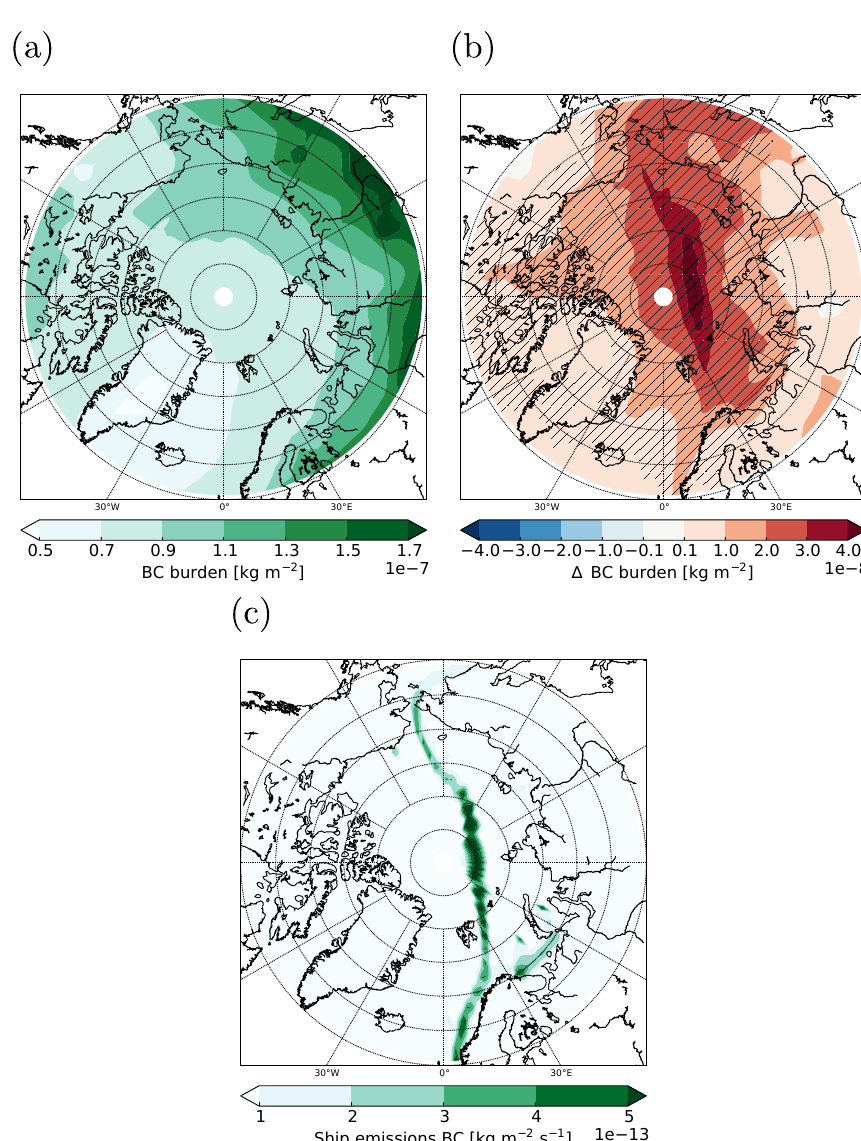
Figure 9. Panel (a) shows the BC burden in 2050 without considering enhanced Arctic ship emissions. Panel (b) shows the difference between a simulation with additional Arctic ship emissions and a simulation without these emissions in 2050 (difference between arc- tic_2050_shipping and arctic_2050). Hatched areas are significant at the 95% confidence level. Panel (c) shows ship emissions of BC (10-fold higher transit- and petroleum-related emissions) in 2050 based on the emission inventory by Peters et al. (2011). All values are for early autumn